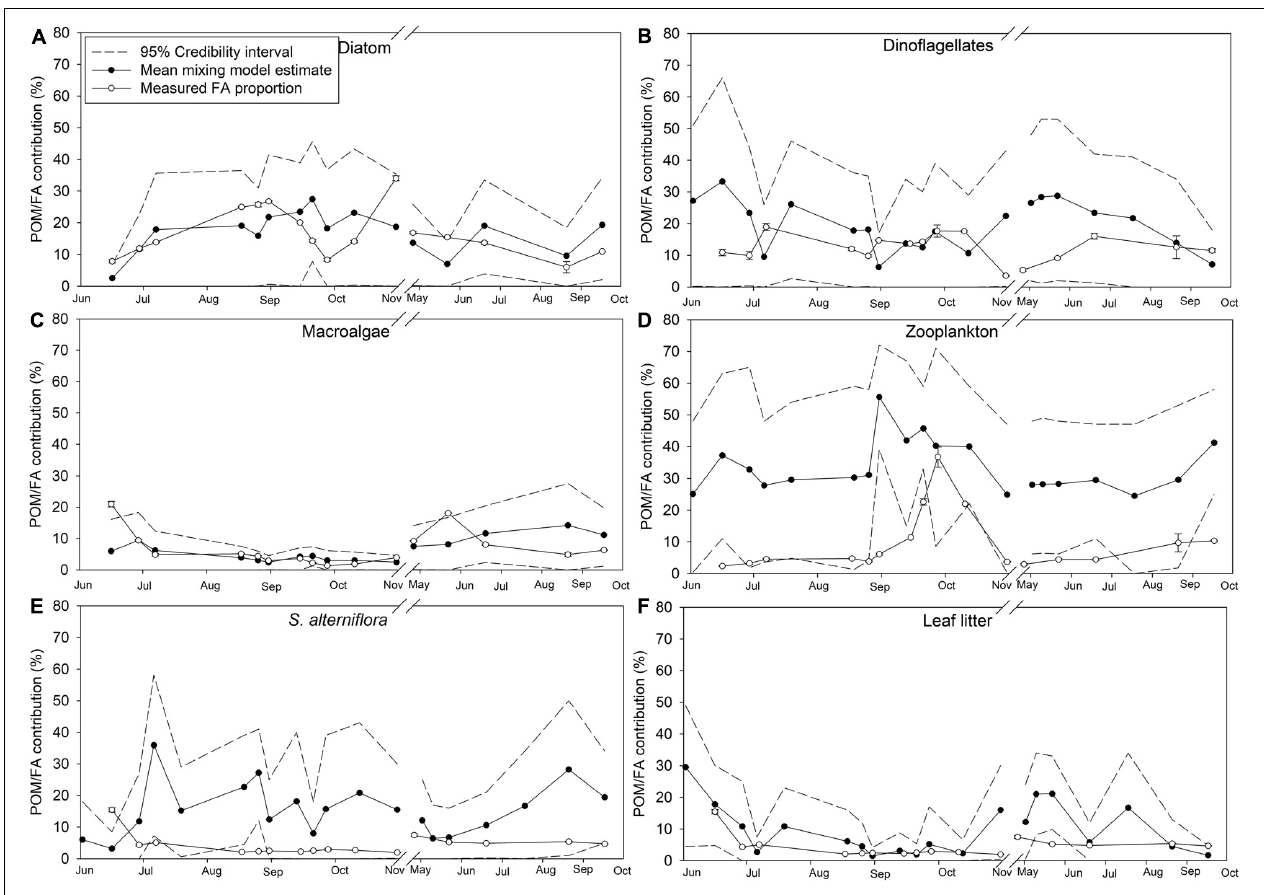
FIGURE 9 | Endmember contribution (%) to particulate organic matter (POM) in Saco Bay, ME, United States, throughout 2016 and 2017. Values shown are the mean POM contribution (%) estimated from the dual isotope ( δ 13 C and δ 15 N) Bayesian mixing model along with accompanying credibility interval (95%) and the proportion (% total FAs) of endmember biomarker FAs measured in POM. Endmembers: (A) Diatom. (B) Dinoflagellates. (C) Macroalgae. (D) Zooplankton. (E) S. alterniflora . (F) Leaf litter. Values shown are average ± 1 standard